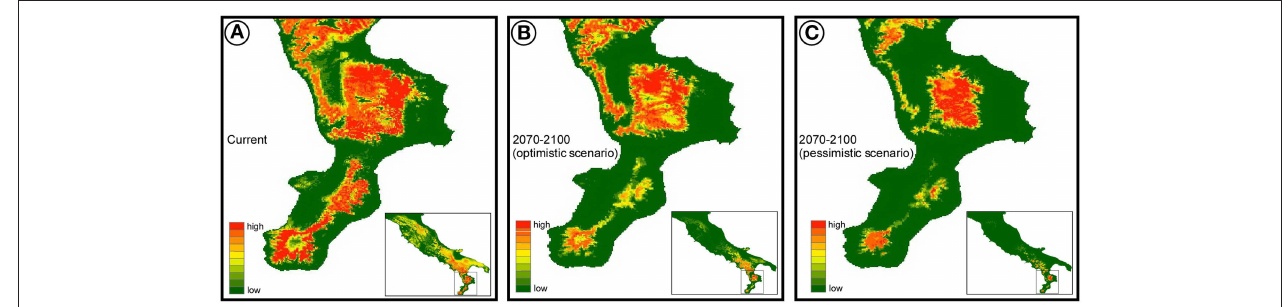
FIGURE 2 | Species distribution model estimated for Bombina pachypus under current bioclimatic conditions (A) , and its projection to the near future (2070–2100), under optimistic (B) and pessimistic (C) scenarios of greenhouse gas emission (RCP2.6 and RCP8.5,